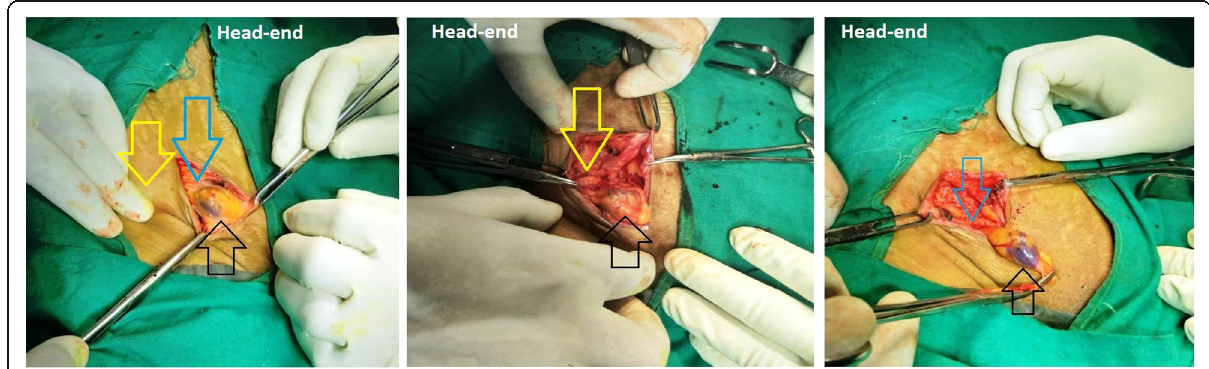
Fig. 3 Intraoperative finding of the intact femorocele sac (thick-walled cyst containing amber-colored fluid) coming out of the femoral ring. Blue arrows, position of the inguinal ligament; black arrow, femorocele sac; yellow arrow, enlarged superficial inguinal lymph